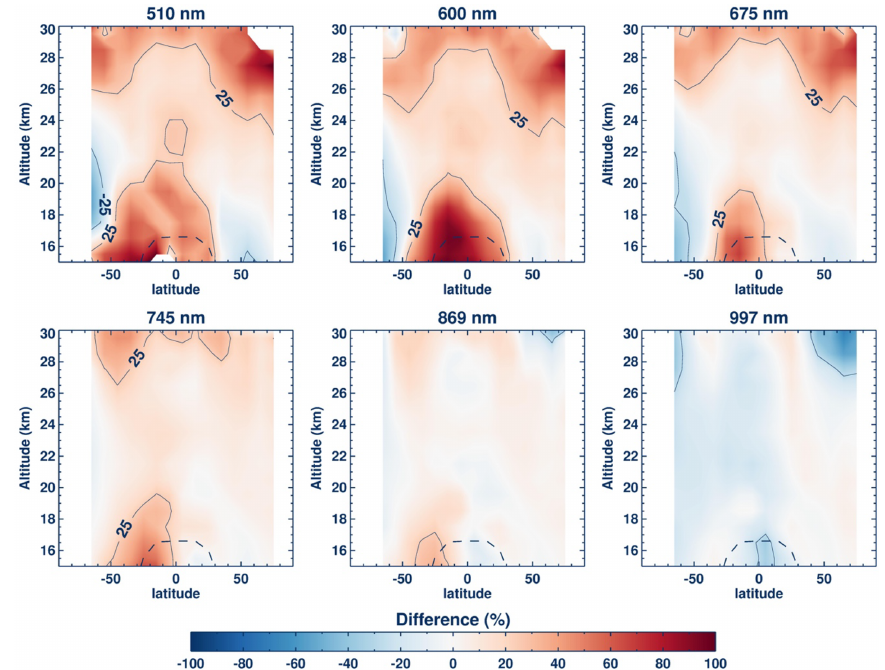
Figure 7. Mean differences between OMPS LP and SAGE III extinctions as a function of latitude and altitude at 510, 66, 675, 745, 869 and 997nm, zonally averaged at 10 ◦ latitudes. The contour line shows differences greater than ± 25%, and dashed line is the tropopause altitude. Positive differences (in percent) indicate the OMPS LP values are higher than SAGE III/ISS.